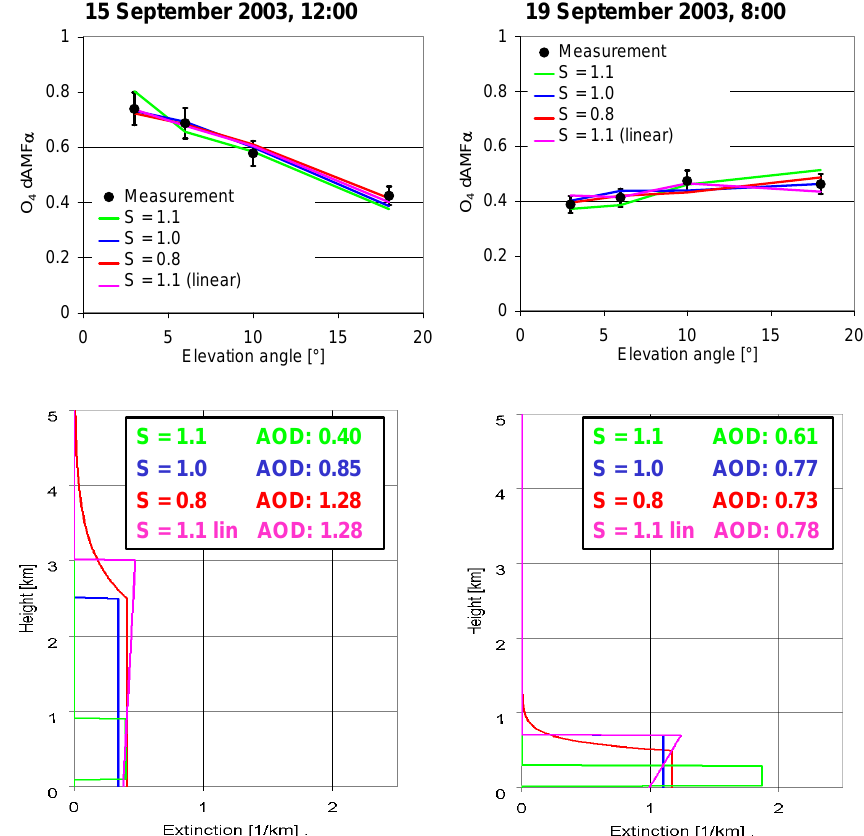
Fig. 3. Top: comparison of measured O 4 dAMF α (black dots) to the results of the forward model (coloured lines) for the southern telescope. The different colours indicate fit results for different shape parameters. The error bars indicate the errors of the spectral analysis. Both observations were made under clear sky conditions. Bottom: resulting aerosol extinction profiles retrieved from the O 4 dAMF α .